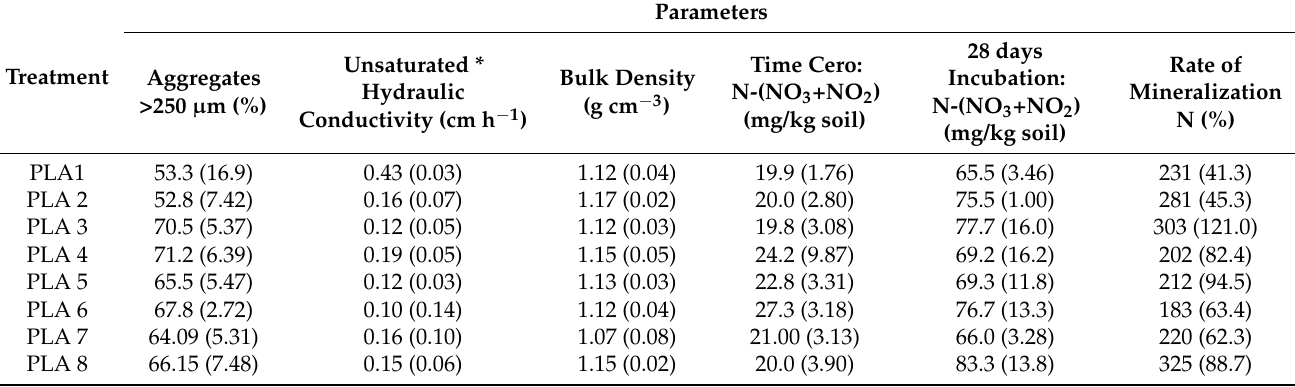
Table 4. Comparison of soil parameters among treatments. Mean values (Stdev). No significant differences among treatments according to one way ANOVA and Tukey pairwise comparison. * No significant differences among treatments according Kruskal–Wallis non-parametric analysis.